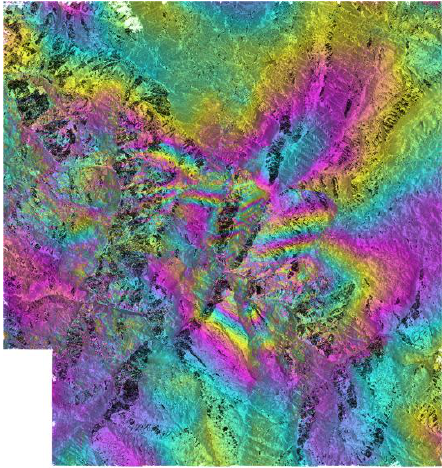
Figure 7 Map of deformation (after